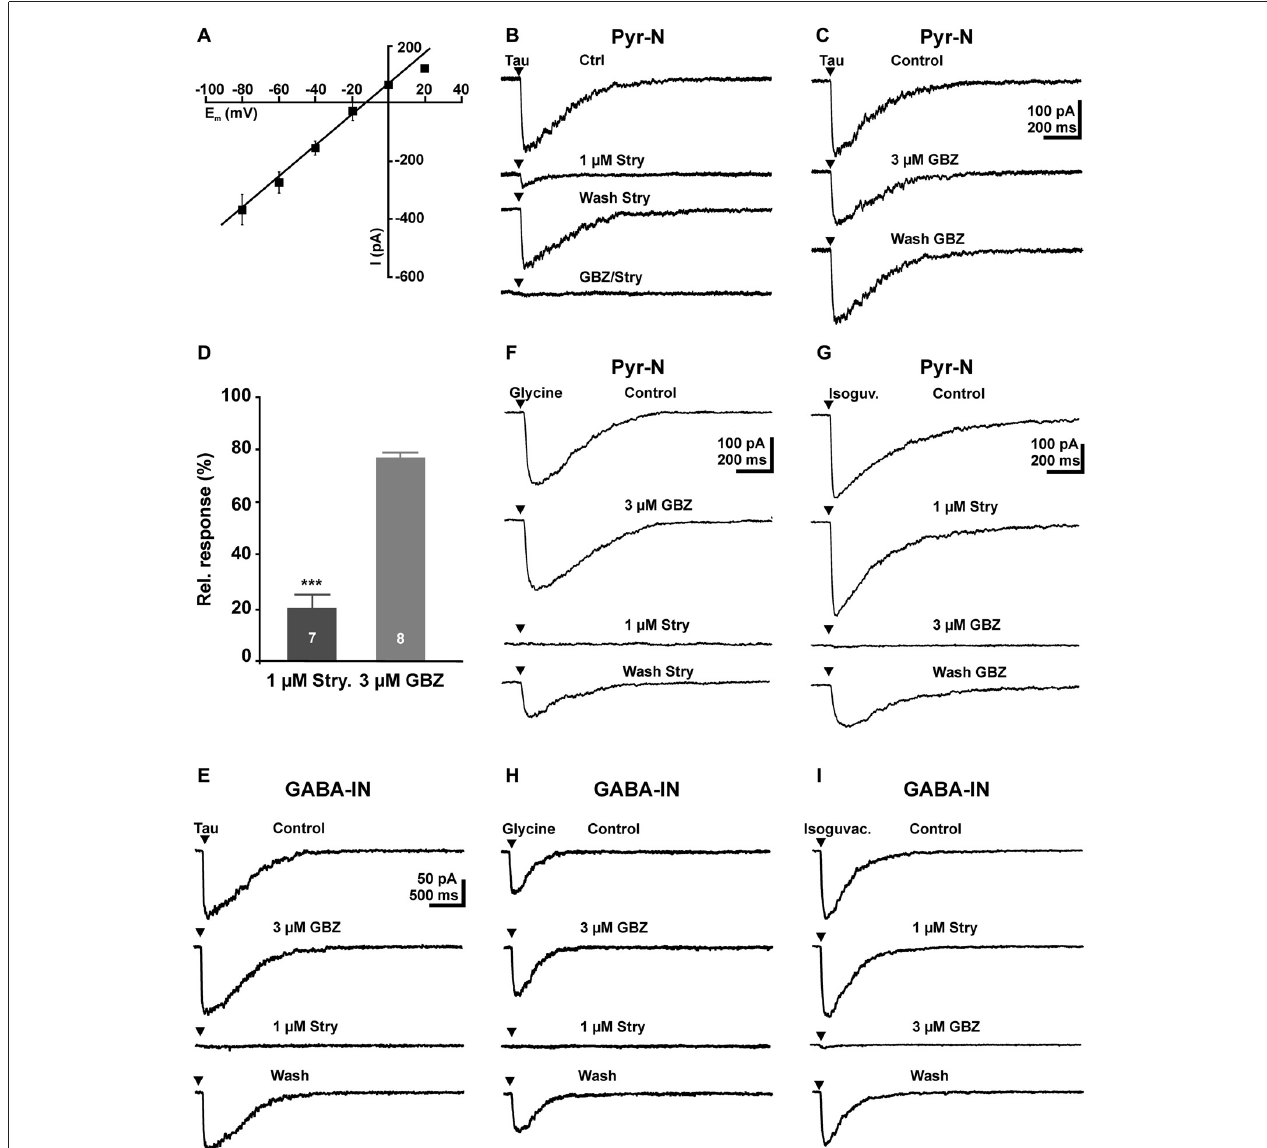
FIGURE 2 | Activation of GABA A and glycine receptors by focal application of 5 mM taurine in pyramidal neurons and GABAergic interneurons . (A) Current-voltage (I–V) plot of the inward current after focal application of 5 mM taurine at different voltages. Note the linear I–V relation and that the current reversed close to the estimated reversal potential. (B) Inward currents elicited by a 5 ms application of 5 mM taurine (Tau)